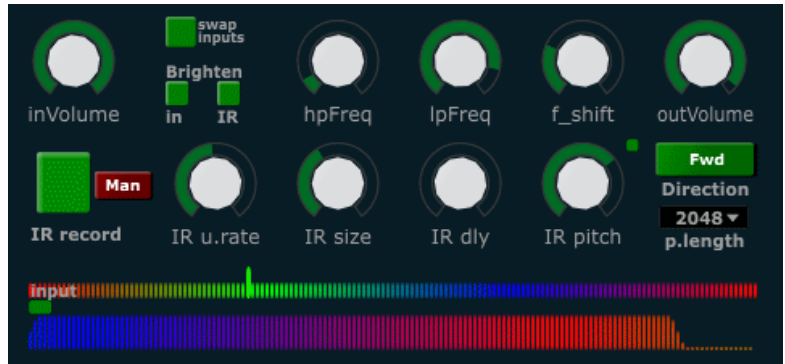
Figure 13. Liveconvolver instrument user interface. As an attempt to visualize when the impulse response is taken from, we use a circular colouring scheme to display the circular input buffer (thin coloured band labeled “input” in the image). We also represent the IR (broader coloured band at the bottom of the image) using the same colours. Time (of the input buffer) is thus represented by